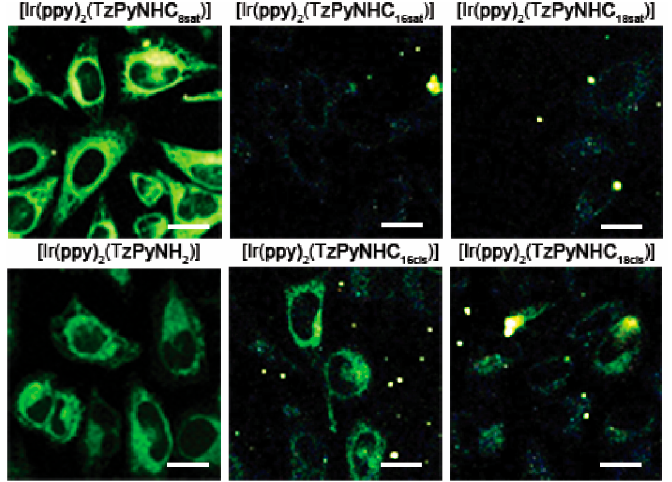
Figure 5. Micrographs of live HeLa cells stained with 5 µM of the reported iridium complexes. Scale bar = 20 µm.